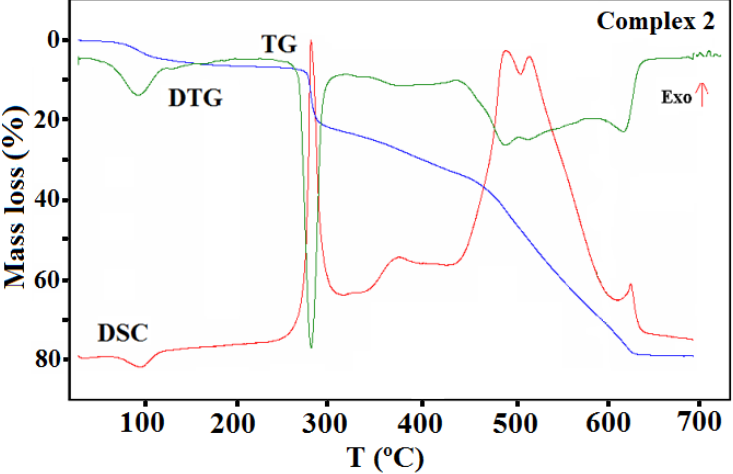
Figure 12. FTIR spectra of the gaseous products evolved during the decomposition process of 1.